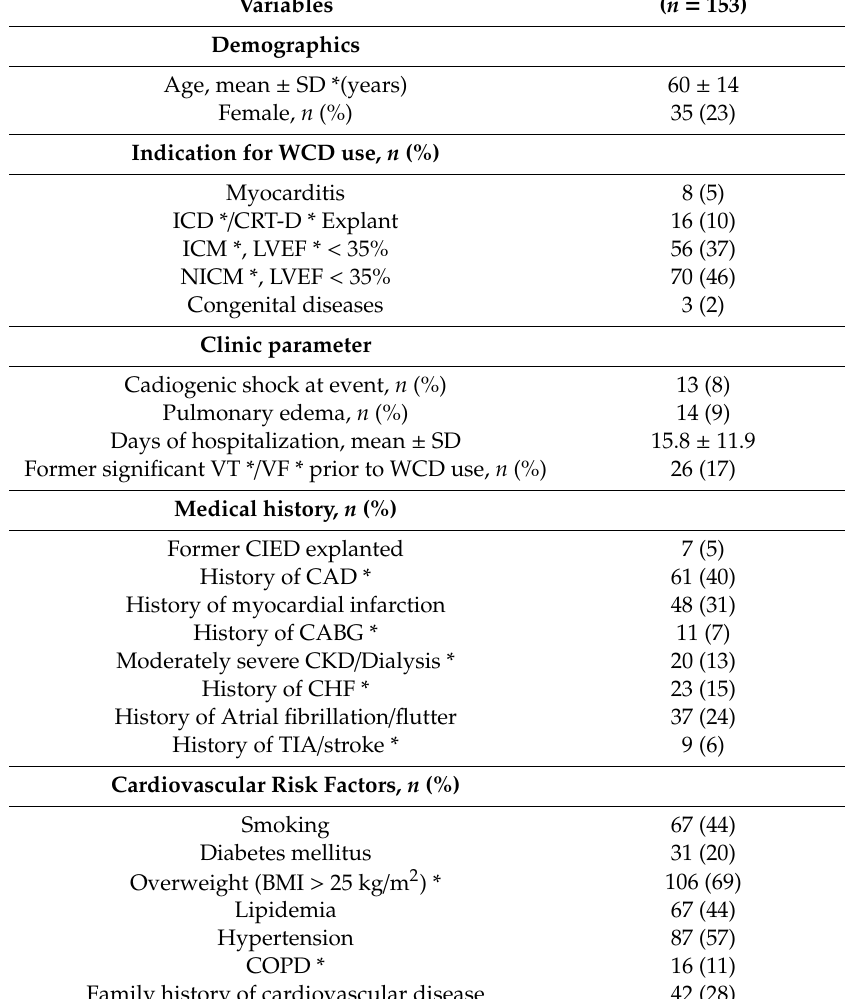
Table 1. Baseline characteristics of 153 patients with wearable cardioverter defibrillator